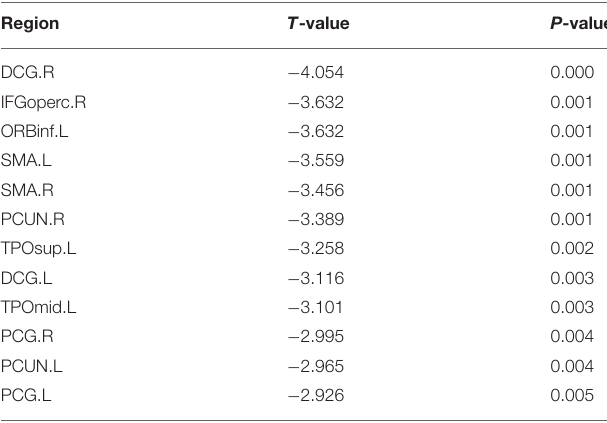
TABLE 4 | Brain regions with significant differences in nodal efficiency among the two groups. Region T -value P -value DCG.R − 4.054 0.000 IFGoperc.R − 3.632 0.001